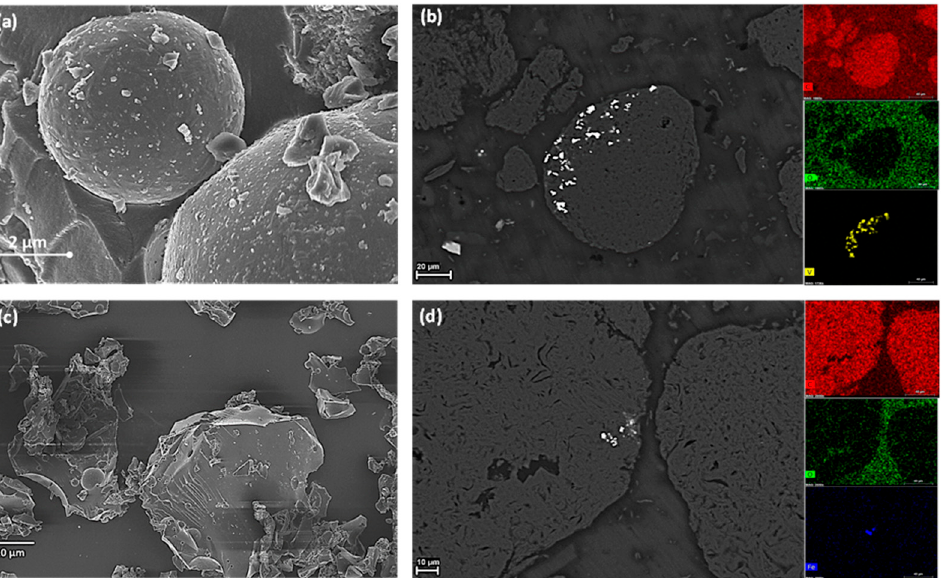
Figure 8. Morphology of de-mineralized c-PET/d-coal ash composite particles derived from co-carbonization of a 3:1 w-PET/d-coal ash composite: ( a ) FIB-SEM image showing 3D surface of spherical particles (at 10,000× magni fi cation); ( b ) SEM image of the cross-sectional surface of spherical particles; ( c ) FIB-SEM image showing 3D image of irregularly shaped particles (at 1000× magni fi cation); and ( d ) SEM images of the cross-sectional area of irregularly shaped particles.